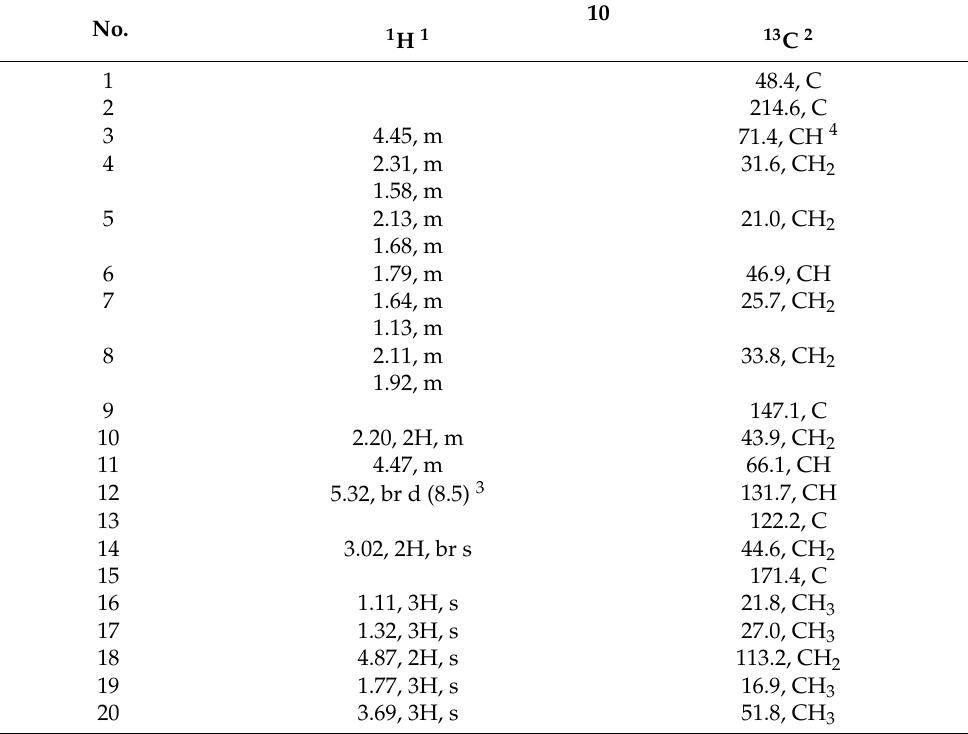
Table 5. 1 H and 13 C NMR spectroscopic data of compound 10